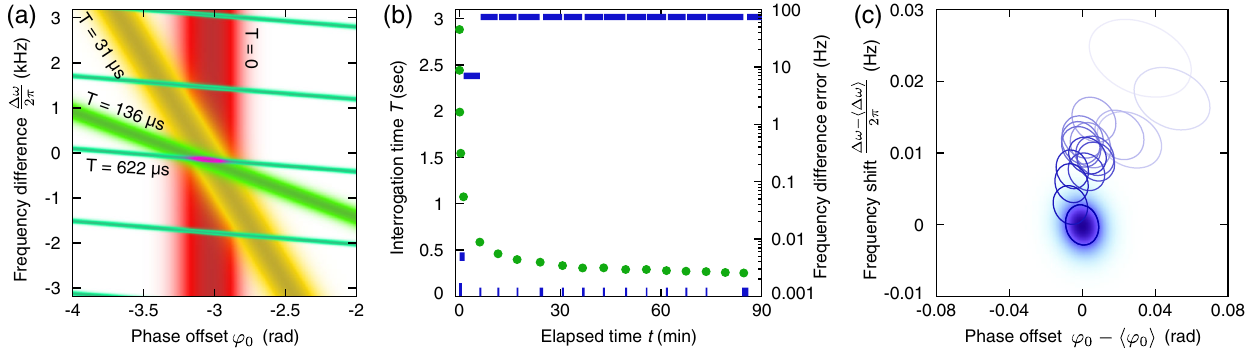
FIG. 4. Bayesian evaluation of a measurement at an ion distance of d ¼ 800 μ m. (a) Update functions (colored bars) in ð Δ ω ; φ 0 Þ - parameter space of the first four phase measurements with N ¼ M ¼ 50 repetitions of the experimental procedure and the posterior PDF (purple ellipse) after these iterations. (b) Interrogation times (blue bars) and error of the frequency determination (green points) for each phase measurement versus elapsed measurement time. (c) The posterior PDFs at maximum interrogation time for subsequent phase measurements are visualized by open ellipses, corresponding to the 39.4%-credible regions. One can see that in this regime, the measurement is tracking the drift of the magnetic-field difference (see text). The posterior PDF pertaining to the last measurements is indicated as a density